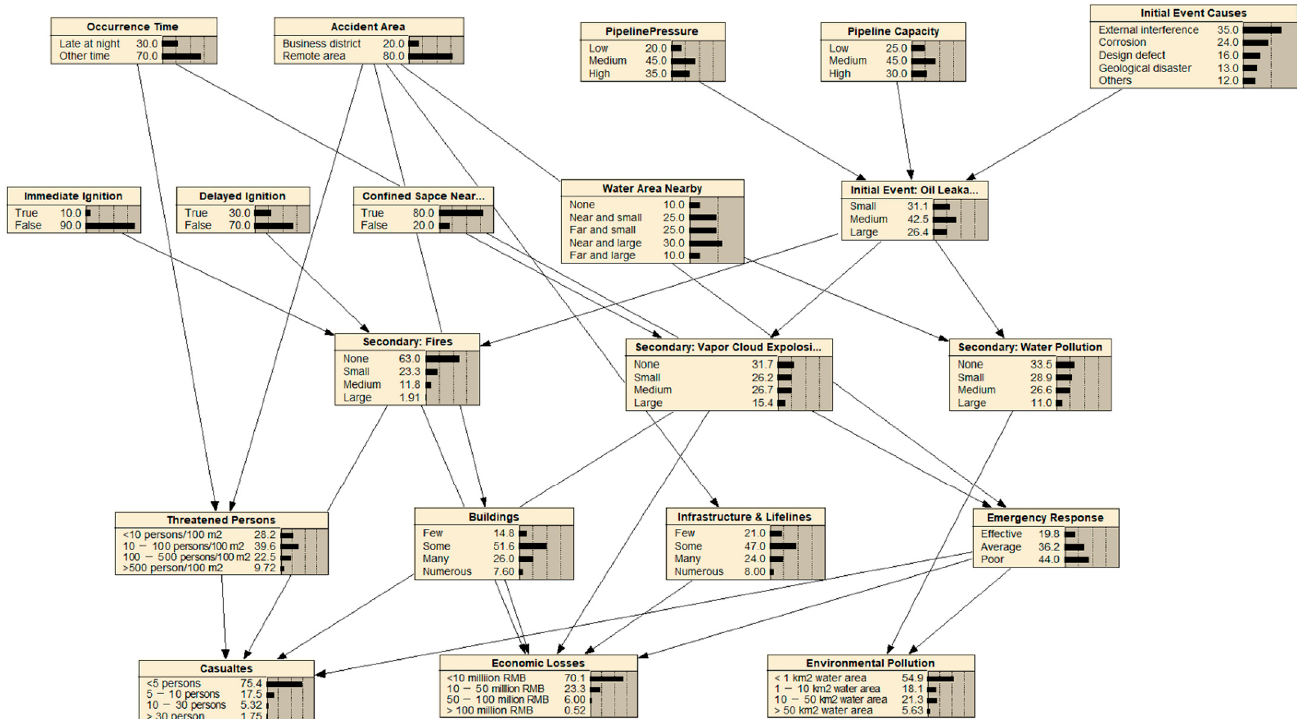
Figure 5. The BN risk analysis model for oil pipeline accidents.